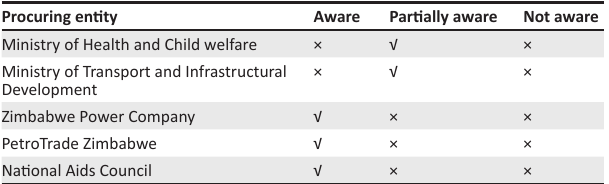
TABLE 4: Awareness of public procurement